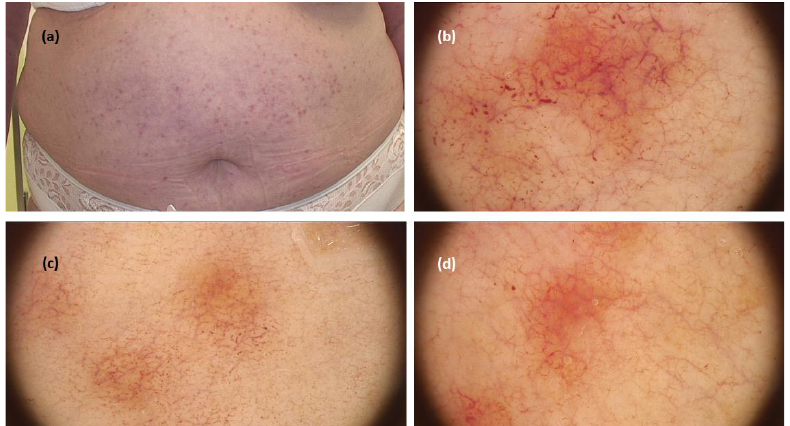
Figure 3. ( a ) Maculopapular cutaneous mastocytosis (telangiectasia macularis eruptiva perstans clinical subtype) — clinical presentation. ( b – d ). Dermoscopy shows reticular vascular pattern (thin reticular telangiectasias) over erythematous background (FotoFinder, Medicam 800 HD, FotoFinder Systems GmbH, Bad Birnbach, Germany; ×20 magnification, immersion